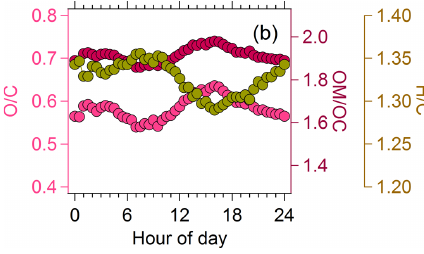
Fig. 9. Diurnal profiles of OM/OC, O/C and H/C ratios.